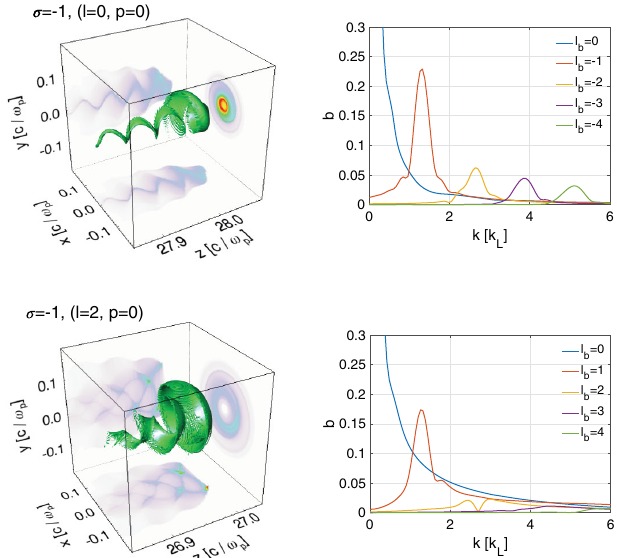
FIG. 4. The structures of the injected electrons at ω when a CP laser pulse with ð σ ¼ − 1 ; l ¼ 0 ; p ¼ 0 Þ or ð σ ¼ − 1 ; l ¼ 2 ; p ¼ 0 Þ is used. The first column: the isosurface of the electron density distribution and its projections on each plane. The second column: the bunching factor of the injected